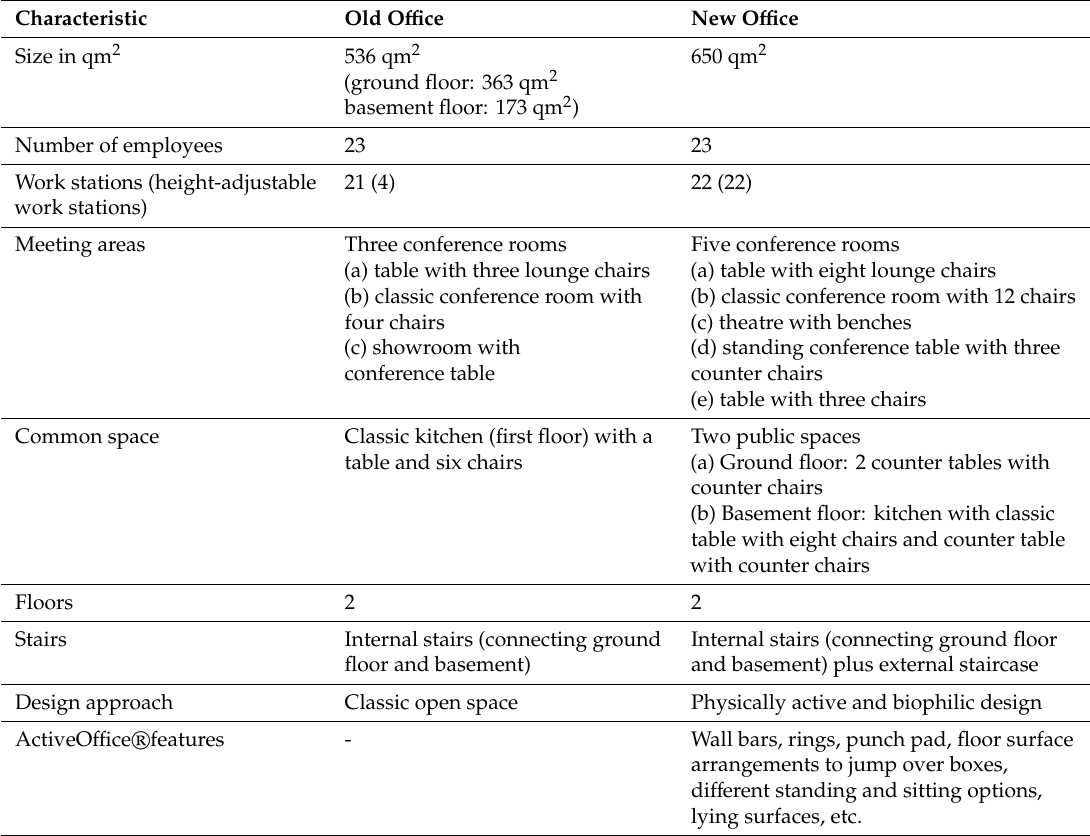
Table 1. Characteristics of the old and new o ffi